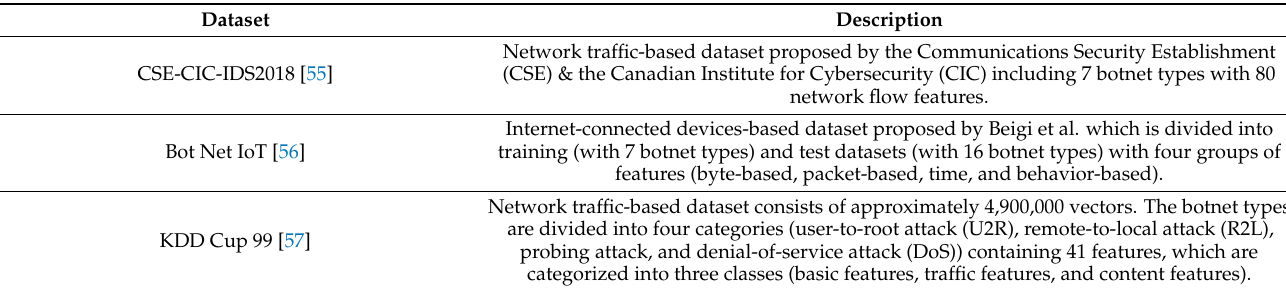
Table 6. Description of used datasets.